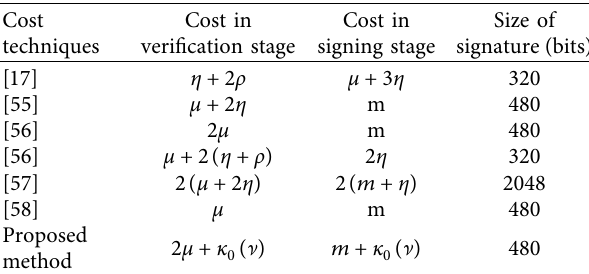
Table 2: Contrast in virtue of the ranked cost and sign measure for ] ⟶